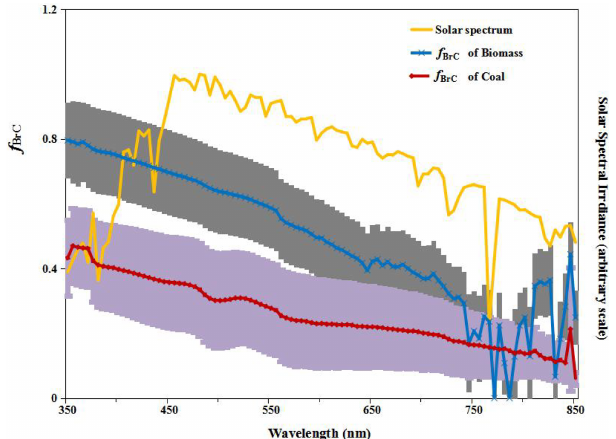
total mass with respect to China’s household biomass and coal burn- ing. Note: the ratio is expressed as f BrC and was calculated in accor- dance with the method described in the Supplement. The yellow line is the clear-sky global horizontal solar spectrum at the Earth’s sur- face for one optical air mass in relative units (Levinson et al., 2010; Chakrabarty et al.,